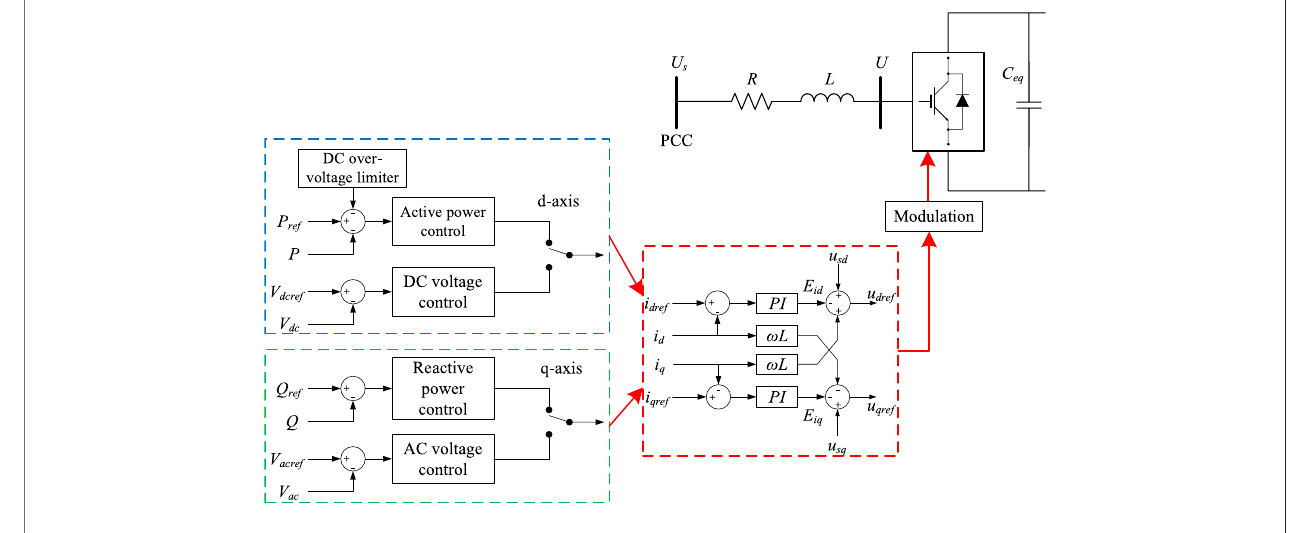
FIGURE 11 | Control architecture of a single MMC.